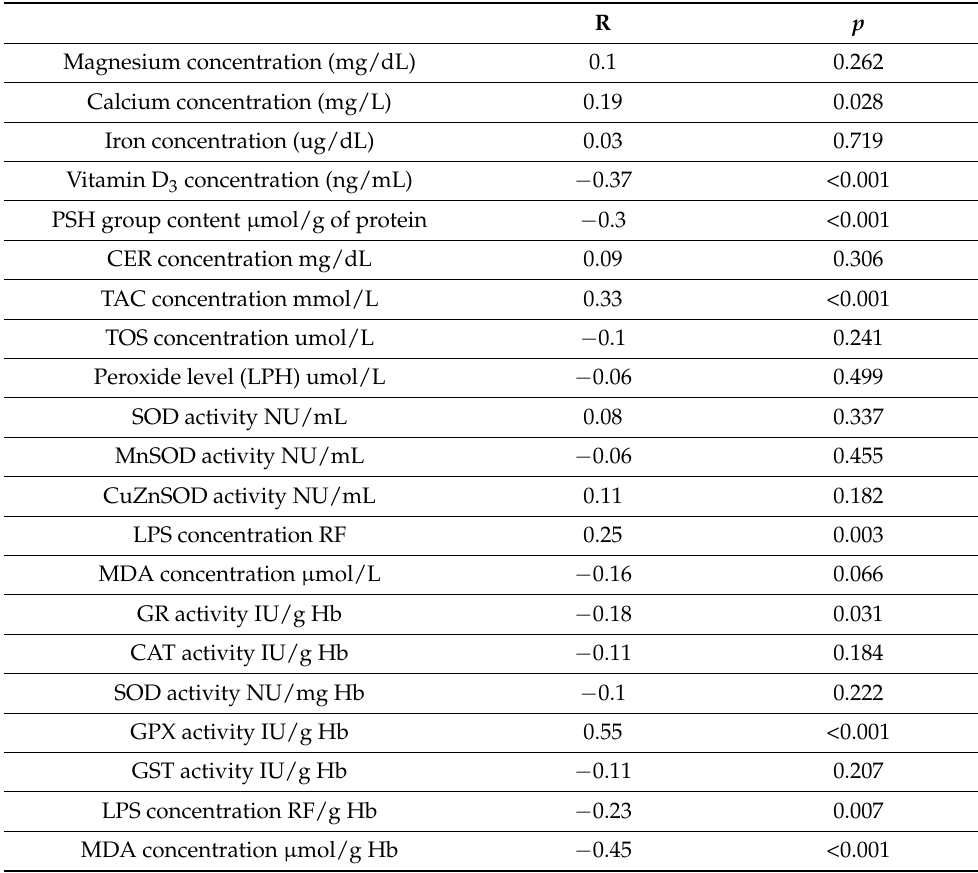
Table 4. Analysis of the correlation between cadmium (CdB) and the investigated parameters (Spearman R correlation coefficient). PSH—protein sulfhydryl groups; CER—ceruloplasmin; TAC— total antioxidant capacity; TOS—total oxidant status; LPH—lipid hydroperoxides; SOD—superoxide dismutase; LPS—lipofuscin; MDA—malondialdehyde; GR—glutathione reductase; CAT—catalase; SOD—superoxide dismutase; GPX—glutathione peroxidase; GST—glutathione